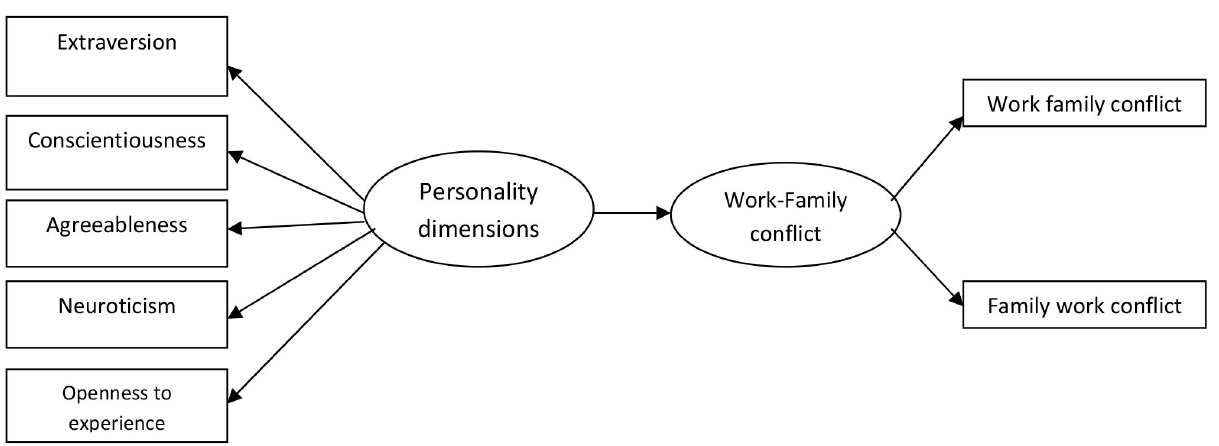
Figure 1. Framework relating personality dimensions with W-F